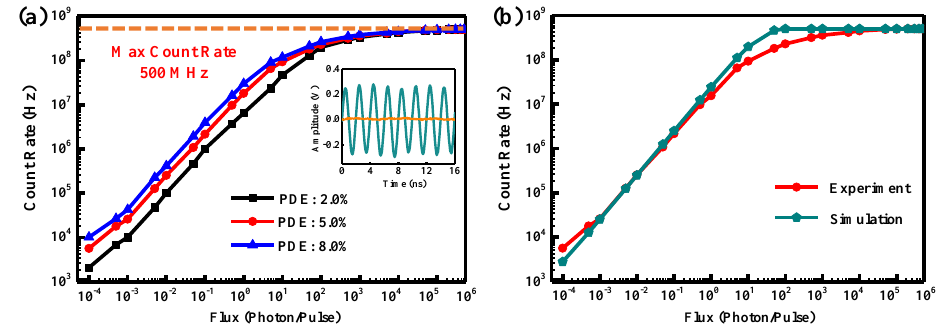
Figure 3. ( a ) Count rate versus flux of the incident laser with different PDEs. Inset: Waveform recorded for the SPAD under an illumination flux of 100 photons per pulse (green line) as well the residual background recorded under no illumination (orange line), respectively. ( b ) Experimental and simulated count rate as a function of the incident photon flux with the PDE of 5.0%.